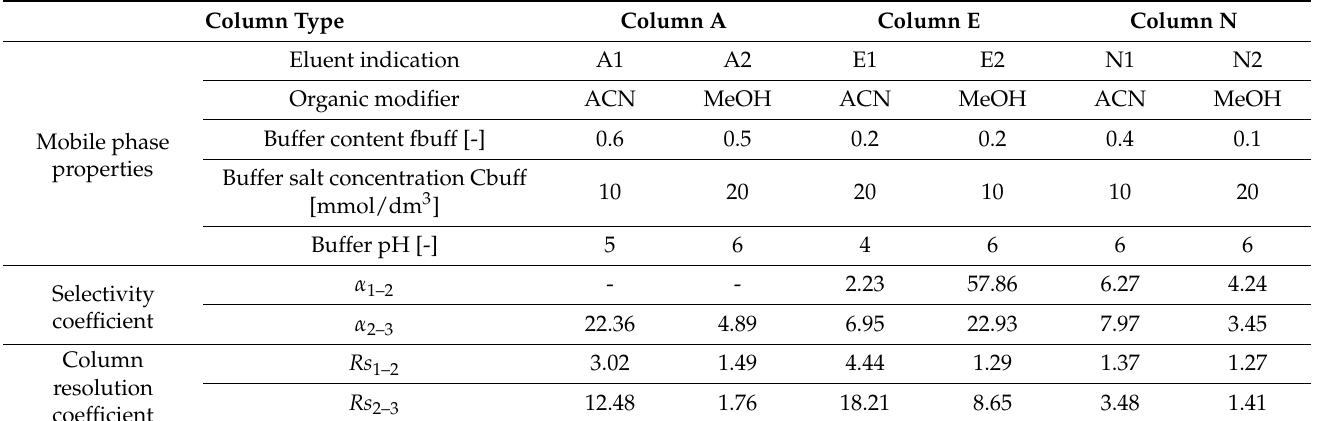
Table 6. The systems selected for optimization of vitamin mixture separation and their performance regarding selectivity and resolution